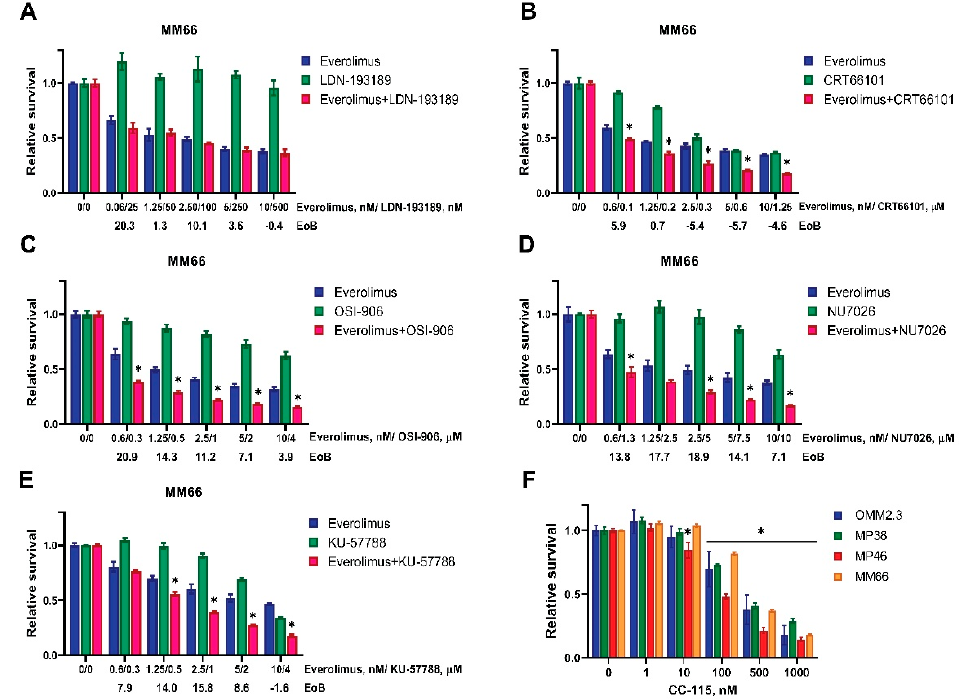
Figure 3. Targeted inhibitors of DNA-PKcs or IGF1R demonstrate synergistic effect in combination with everolimus. ( A – E ) MM66 cells were treated with either everolimus (blue bars) or a targeted inhibitor of ( A ) ALK-2 (LDN-193189), ( B ) PRKD3 (CRT66101), ( C ) IGF1R (OSI-906), ( D ) DNA-PKcs (NU7026), ( E ) DNA-PKcs (KU57788) (green bars), or the combination of both (red) for 5 days to